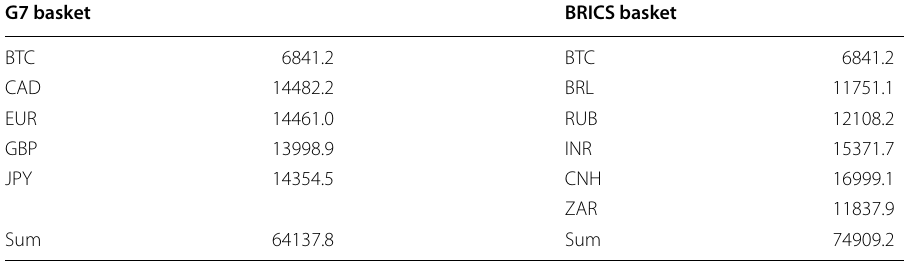
Table 4 Estimation outputs of the marginals